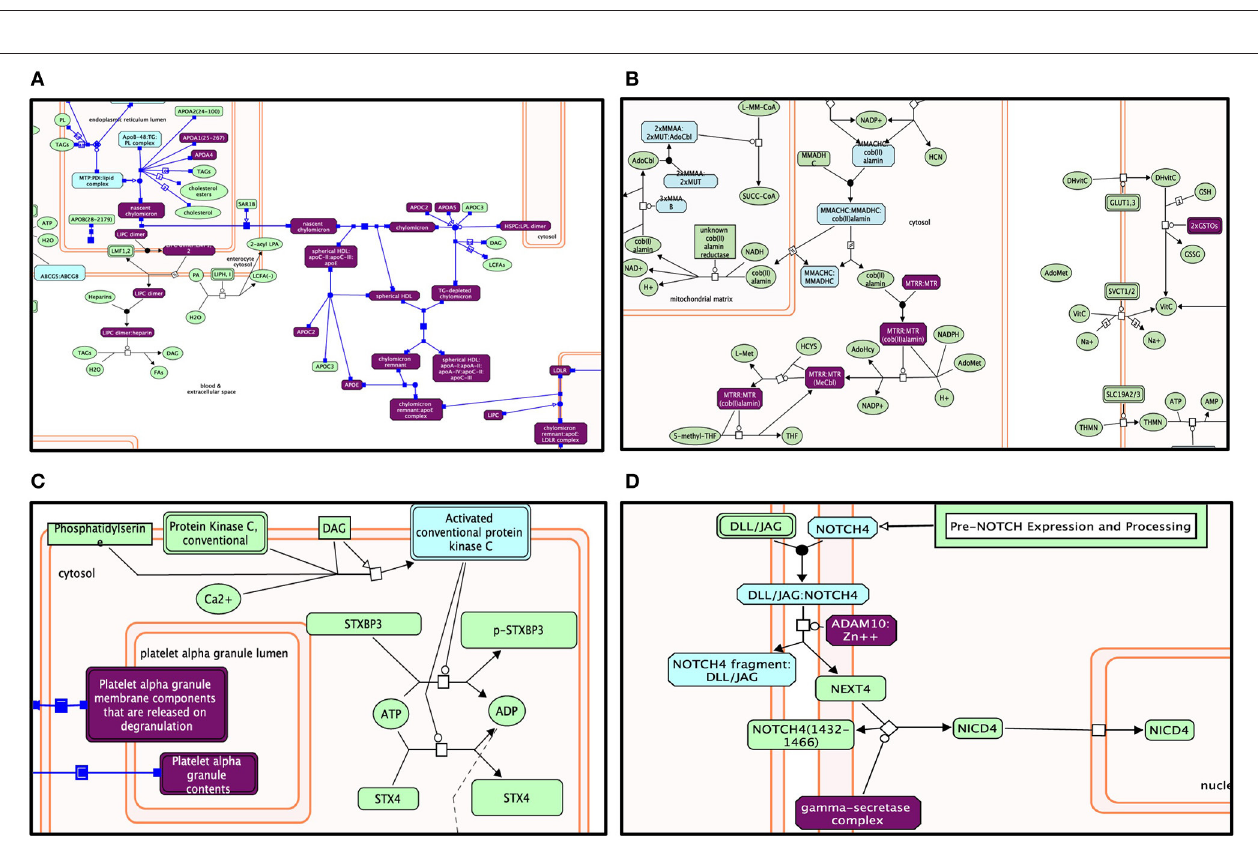
FIGURE 5 | Enriched pathway analysis: The entities in the diagram colored purple are hits within positive gene list. Proteins are rectangles whereas elongated hexagons are complexes. Different Reactome pathways are highlighted in colors corresponding to their FDR values. (A) Lipid digestion, mobilization, and transport. (B) Metabolism of vitamins and cofactors. (C) Platelet activation, signaling, and aggregation. (D) Signaling by NOTCH4.